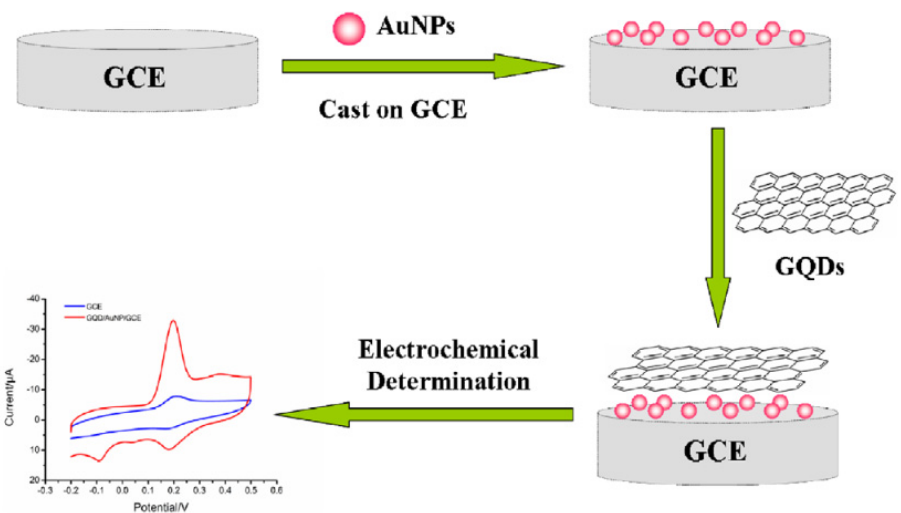
Figure 21. Schematic illustration of assembling of GODs/AuNPs/GCE and the electrochemical de- termination of quercetin (QR). Reprinted with permission from [158]. Copyright 2016,